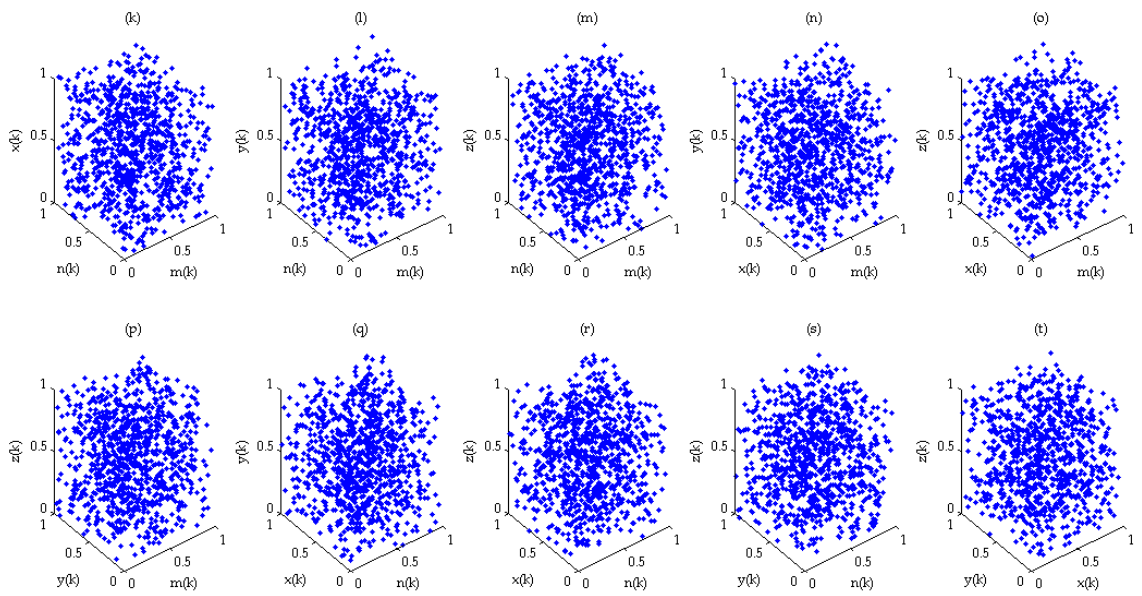
Figure 5. Phase diagram of the five-dimensional system (2): ( a ) M–N phase diagram; ( b ) M–X phase diagram; ( c ) M–Y phase diagram; ( d ) M–Z phase diagram; ( e ) N–X phase diagram; ( f ) N–Y phase diagram; ( g ) N–Z phase diagram; ( h ) X–Y phase diagram; ( i ) X-Z phase diagram; ( j ) Y–Z phase diagram; ( k ) M–N–X phase diagram; ( l ) M–N–Y phase diagram; ( m ) M–N–Z phase diagram; (n) M–X–Y phase diagram; (o) M–X–Z phase diagram; ( p ) M–Y–Z phase diagram; ( q ) N–X–Y phase diagram; ( r ) N–X–Z phase diagram; ( s ) N–Y–Z phase diagram; ( t ) X–Y–Z phase diagram.